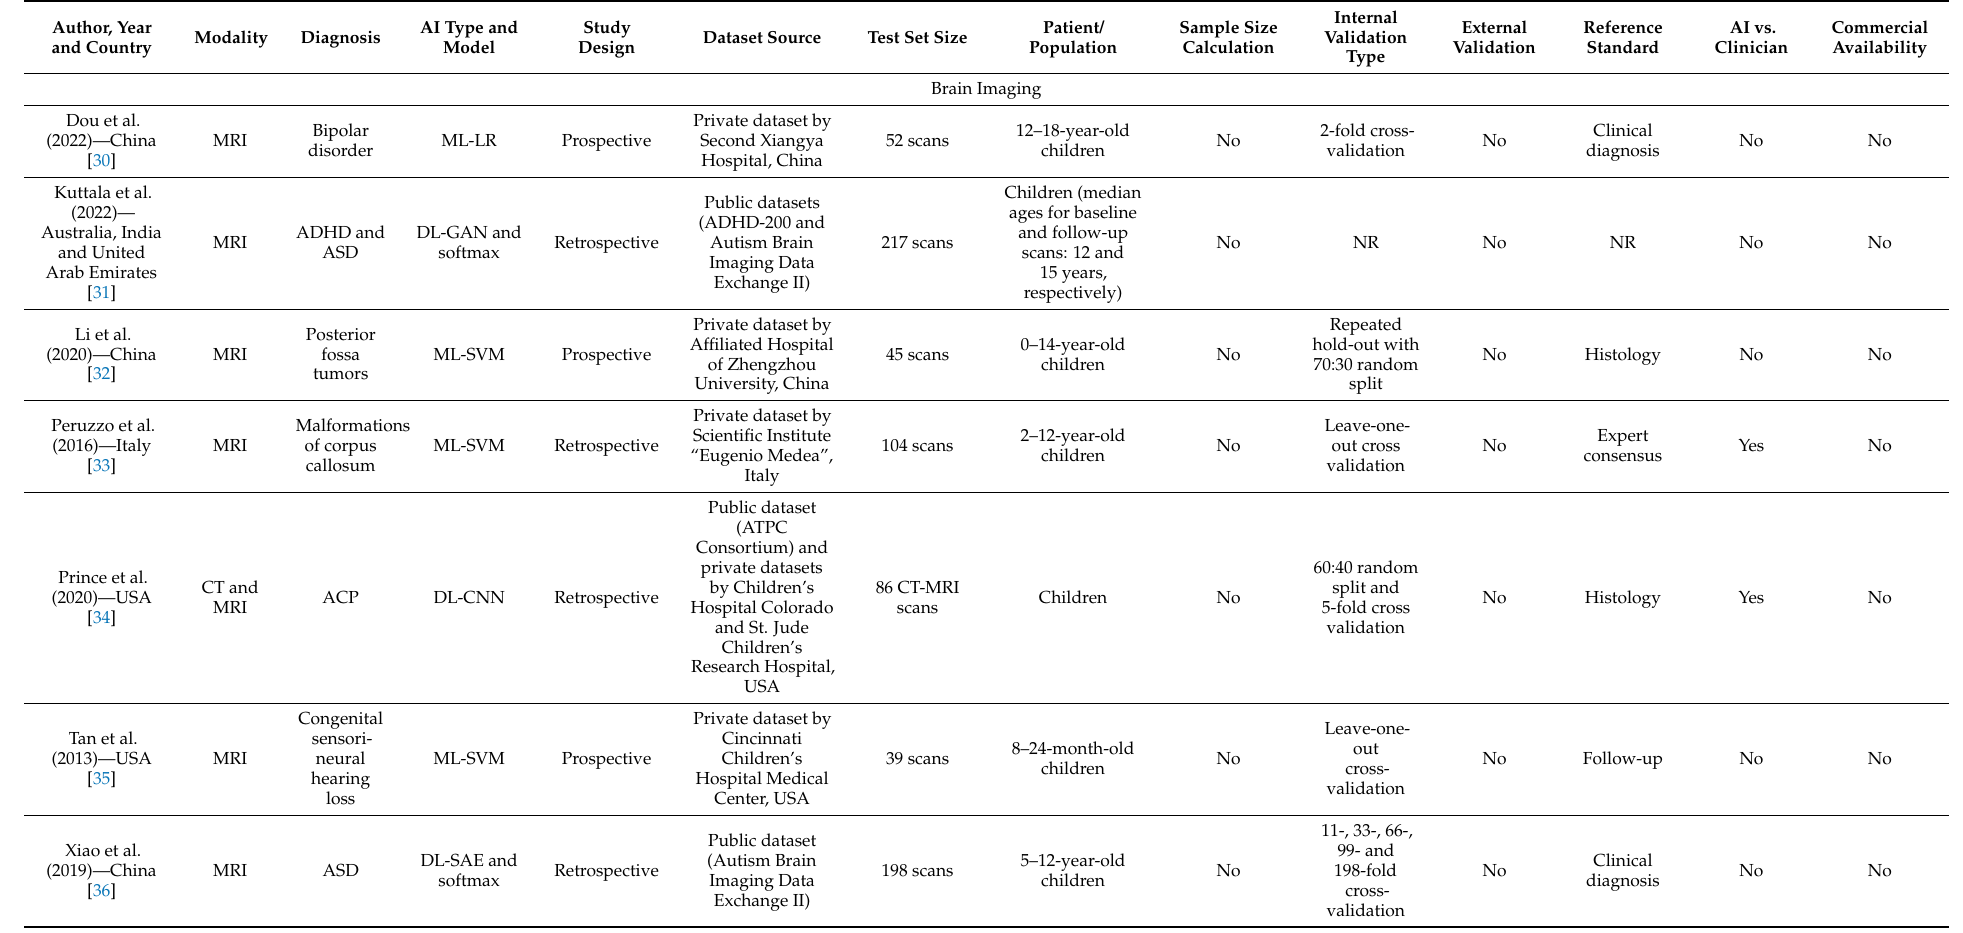
Table 2. Study characteristics of artificial intelligence-based computer-aided detection and diagnosis in pediatric